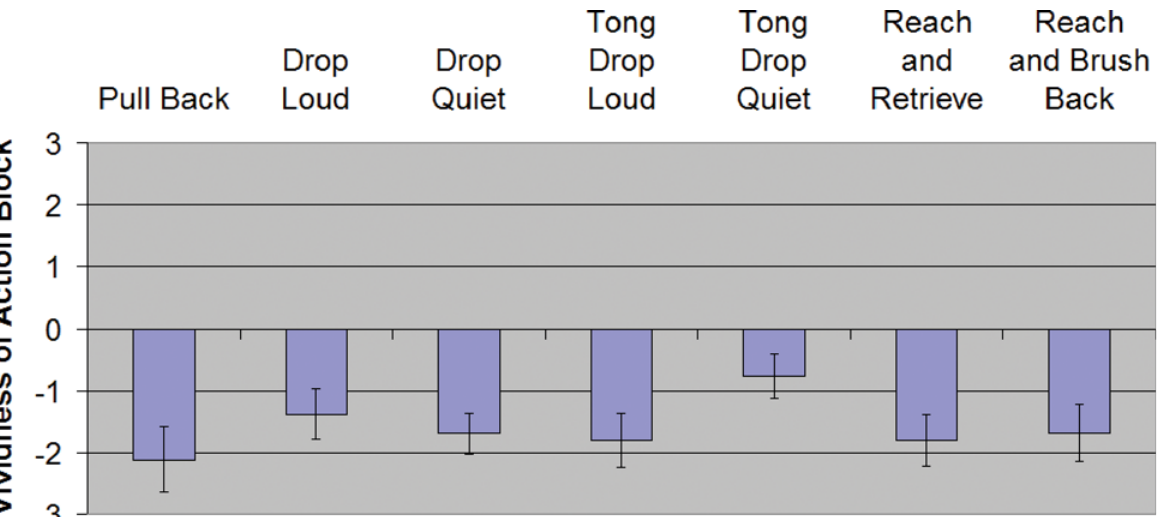
Fig 10. Relative vividness ratings for Experiment 1. Error bars are SEM. Y-axis is the reported vividness of the action block relative to the vividness of the stationary block after the condition's action was performed. Negative values mean the action block was less vivid or faded more than the stationary (control) block.